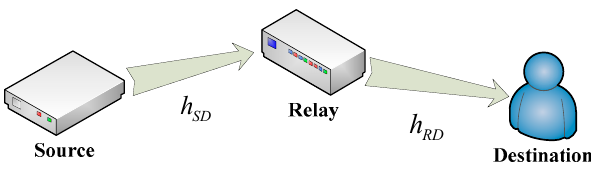
Figure 1. System Figure 1. System model.